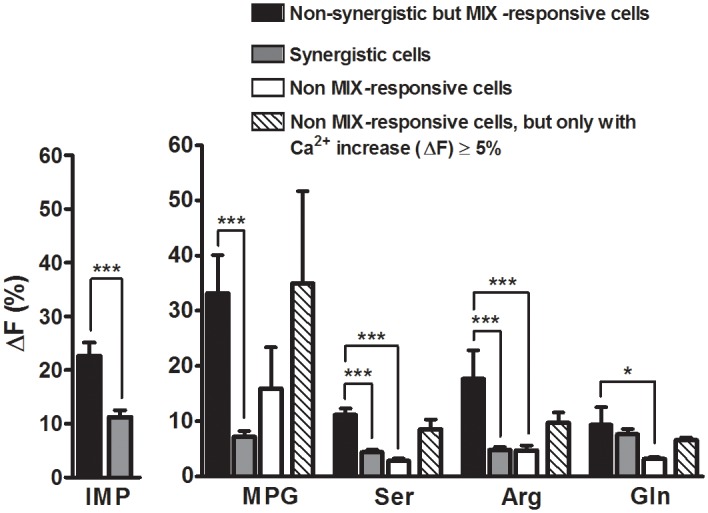
Ca2+ responses to L-amino acids and IMP in MIX-responsive and non-MIX-responsive cells.Bars represent Mean±SEM Ca2+ responses. Average Ca2+ responses to the individual stimulus components of the MIX were compared for two groups of MIX-responsive cells: 1) non-synergistic and 2) synergistic cells. The increases in intracellular Ca2+ in response to IMP and the L-amino acids were significantly smaller for synergistic cells (gray bars) compared to non-synergistic (black bars) MIX-responsive cells. Cells that did not respond to the MIX but responded to an L-amino acid (non-MIX-responsive cells; white bars) presented alone also generated Ca2+ responses with a similar magnitude as those of MIX-responsive non-synergistic cells (gray bars). To eliminate bias by cells that may not have a receptor, only those cells with Ca2+ responses (ΔF≥5%) to L-amino acids were analyzed (see results). For these cells, Ca2+ responses to individual L-amino acids were not significantly different from Ca2+ responses of MIX-responsive, non-synergistic cells (patterned bars). Unpaired t-test (for IMP), and One-way ANOVA followed by Bonferroni post hoc t-test (for L-amino acids) were used for statistical comparison. ***P<0.0001, **P<0.001, *P<0.05.